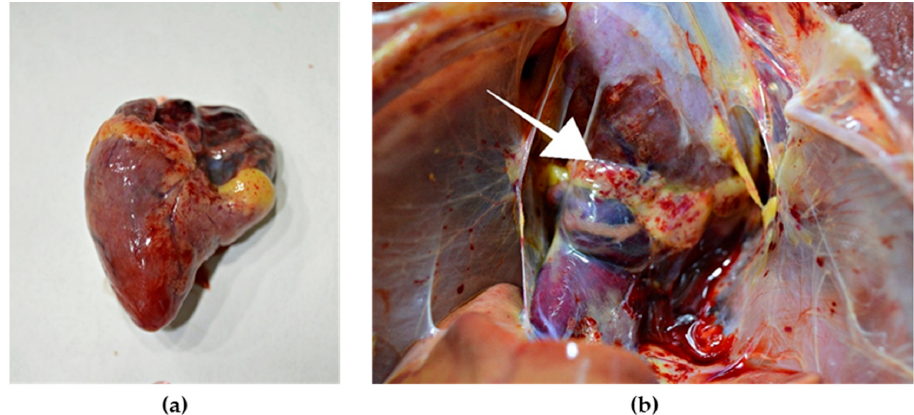
Figure 3. Gross lesions in the heart of chicken naturally infected with HPAI H5N8. ( a ) Petechial hemorrhage in the apical zone and base of the heart. ( b ) Petechial hemorrhage in the epicardial fat (arrow).